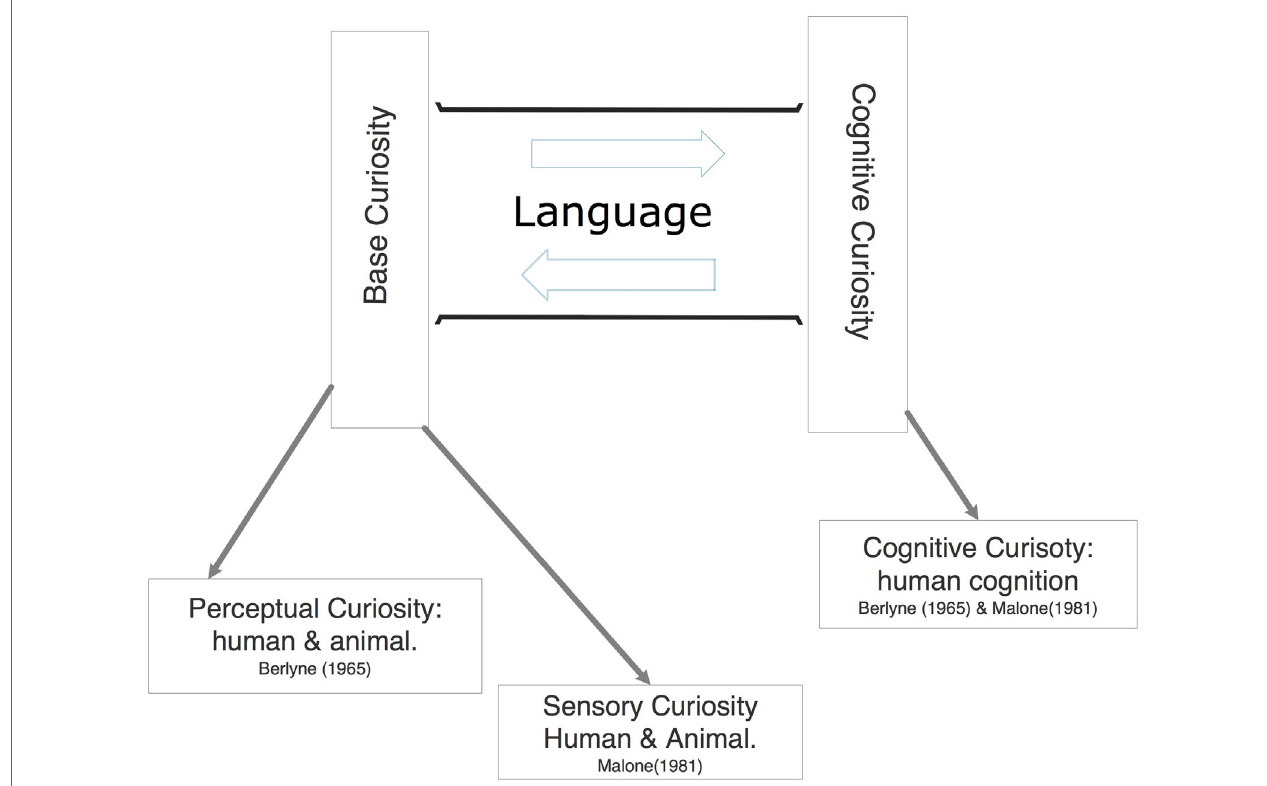
FiGUre 4 | Interplay of language between Base and Cognitive curiosity, and their